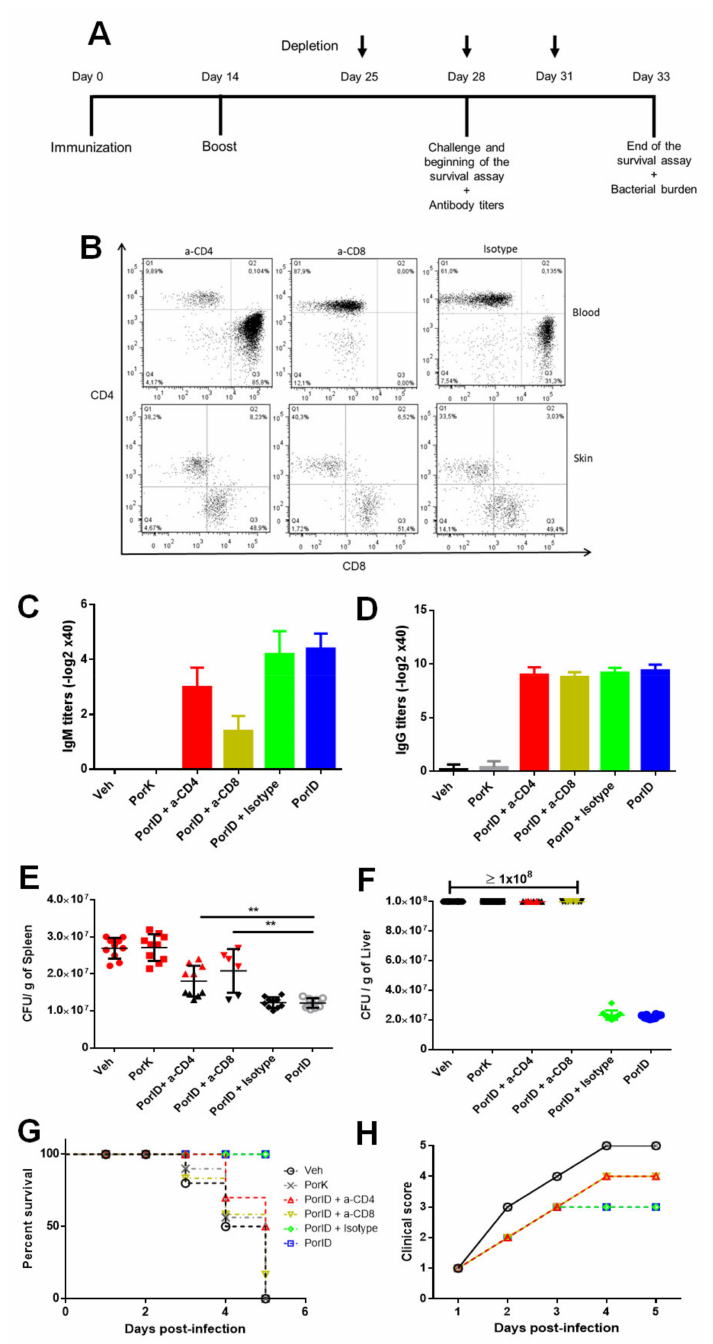
Figure 5. Circulating memory CD4+ and CD8+ T cells are crucial in the protection induced by S . Typhi porins. C57BL/6J mice were injected intradermally in the ear with vehicle (Veh), proteinase K-digested porins (PorK), porins (PorID), or intraperitoneally with porins (PorIP) or heat-inactivated S. Typhi (HIS) at day 0 with a homologous boost at day 14. PorID immunized mice were divided into 4 conditions: anti-CD4 (a-CD4), anti-CD8 (a-CD8), isotype control (Isotype) and no treatment (PorID). At days 25, 28 and 31, CD4+ and CD8+ T cells were depleted with GK1.5 and TIB-210 monoclonal antibodies, respectively, in a-CD4 and a-CD8 groups ( A ). Representative dot-plot of the depletion of circulating CD4+ and CD8+ T cells at day 28 (challenge day) ( B ). IgM ( C ) and IgG ( D ) serum titers were measure before challenge at day 28. Mice were challenged with 10 8 S . Typhi CFU and bacterial burden in spleen ( E ) and liver ( F ) was quantified at 5 days post-challenge (mice that succumbed during challenge are marked in black). Mouse survival ( G ) and clinical scores ( H ) were recorded once daily for 5 days post-challenge ( n = 10; 3 independent experiments; significant difference for a Kruskal–Wallis test ** p < 0.05 with Dunn’s multiple